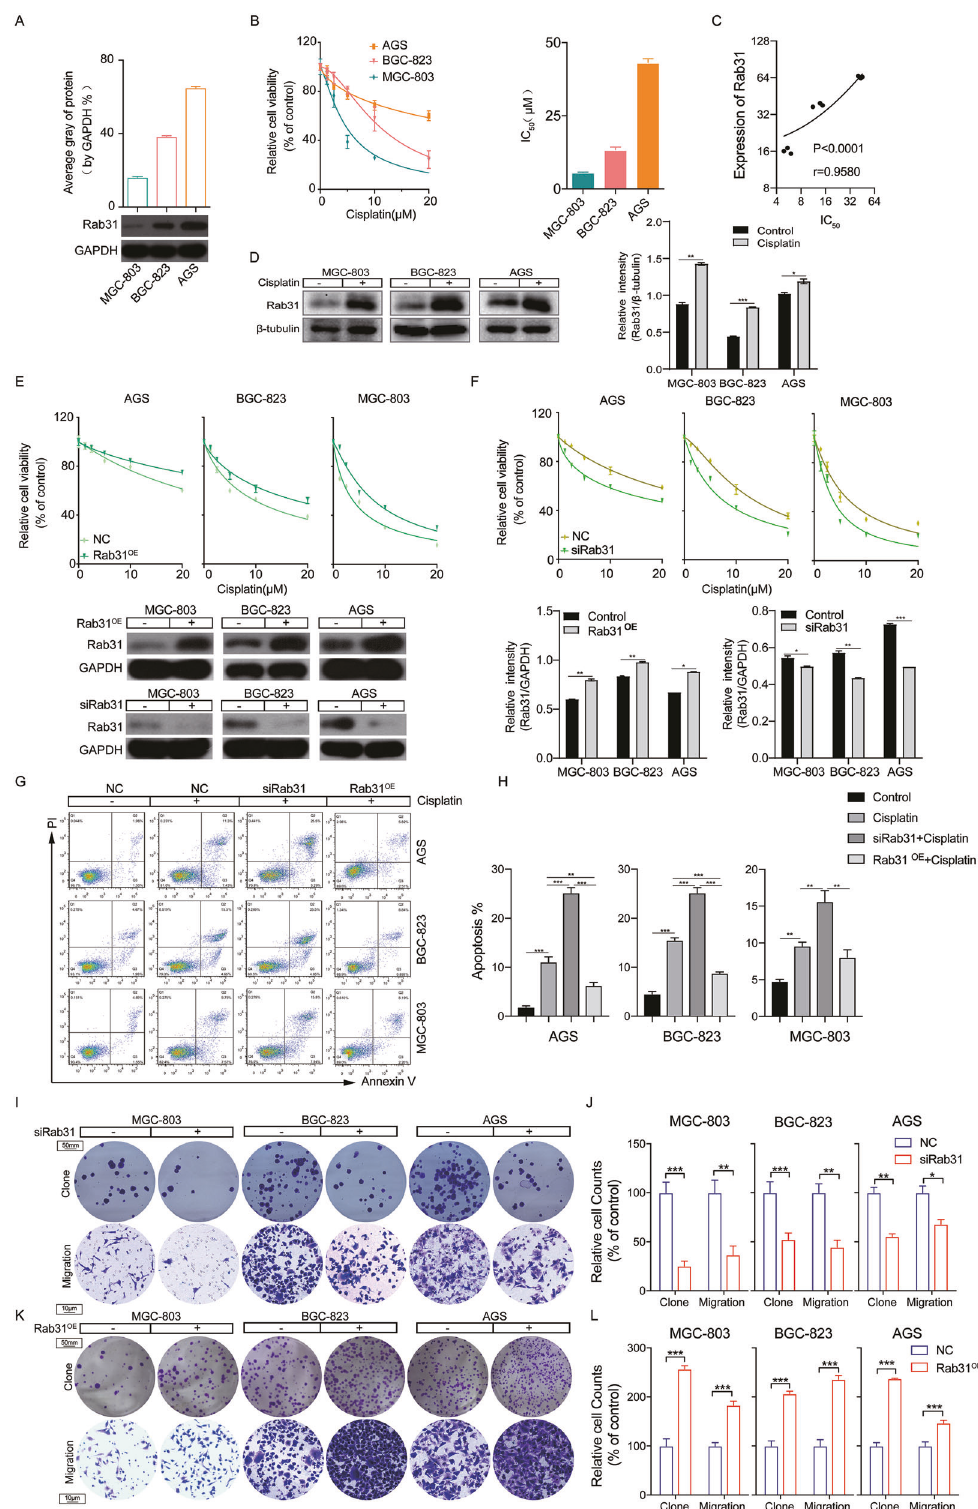
Twist1 in AGS cells (Fig. 4B). The expression levels of Twist1 and Rab31 are positively correlated ( r 2 = 0.9079, P < 0.0001; Fig. 4C). Silencing MUC1-C could inhibit Twist1 and thereby reverses the paclitaxel resistance in triple-negative breast cancer [18]. Here we examined whether MUC-1 is involved in the Rab31-Twist1